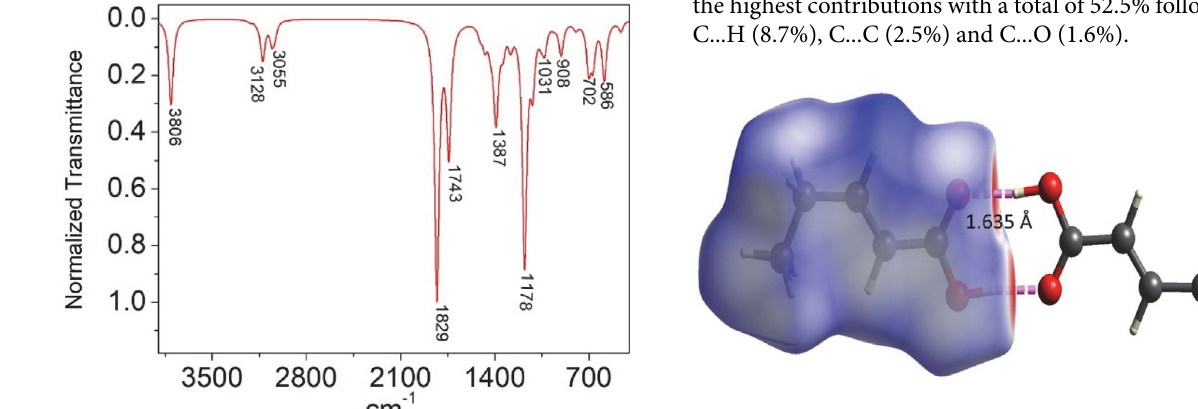
Figure 5: The Hirshfeld surface d norm mapped of C 5 H 8 O 2 for visual- izing the intercontacts, showing molecules are linked into cen- trosymmetric dimers via pairs of O—H...O hydrogen